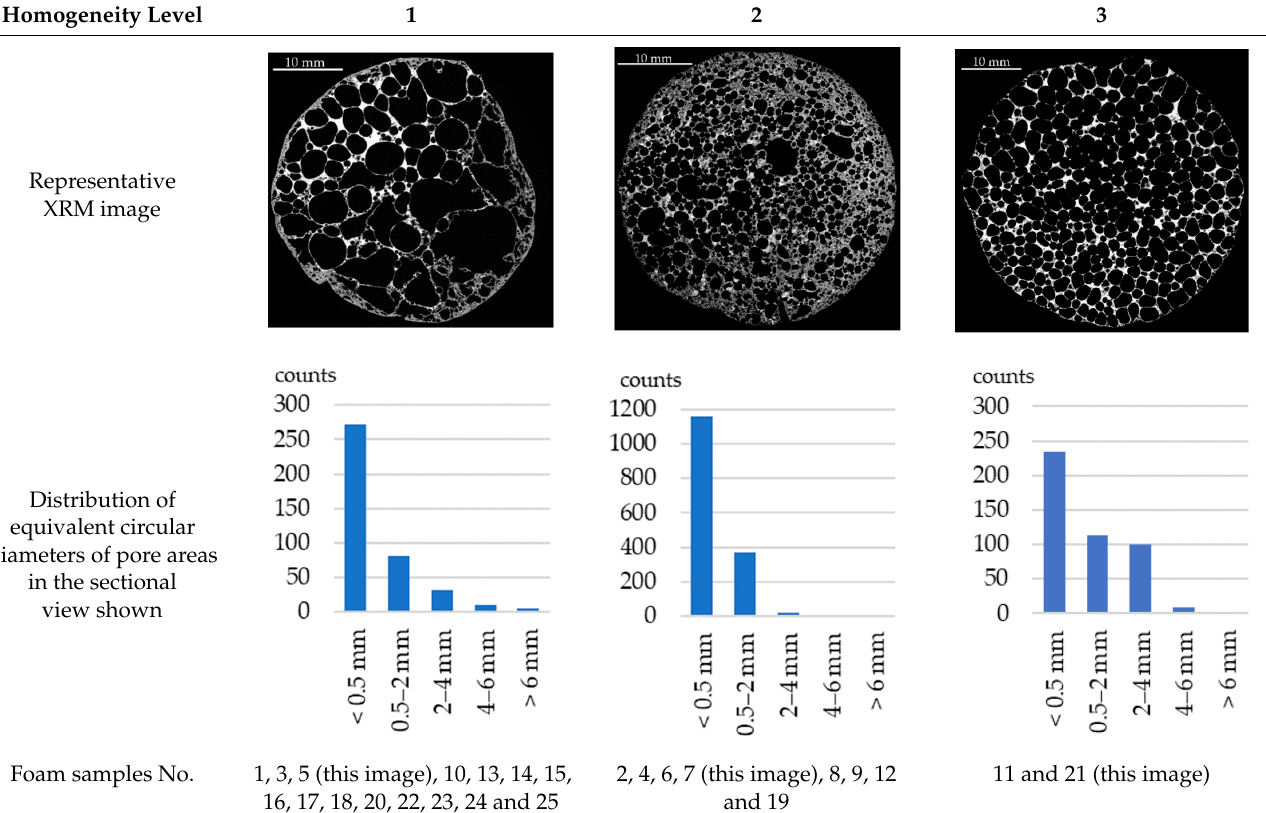
Table 7. Classification of the foam samples into the three homogeneity levels; note the different scales of the y ‐ axis. Homogeneity Level